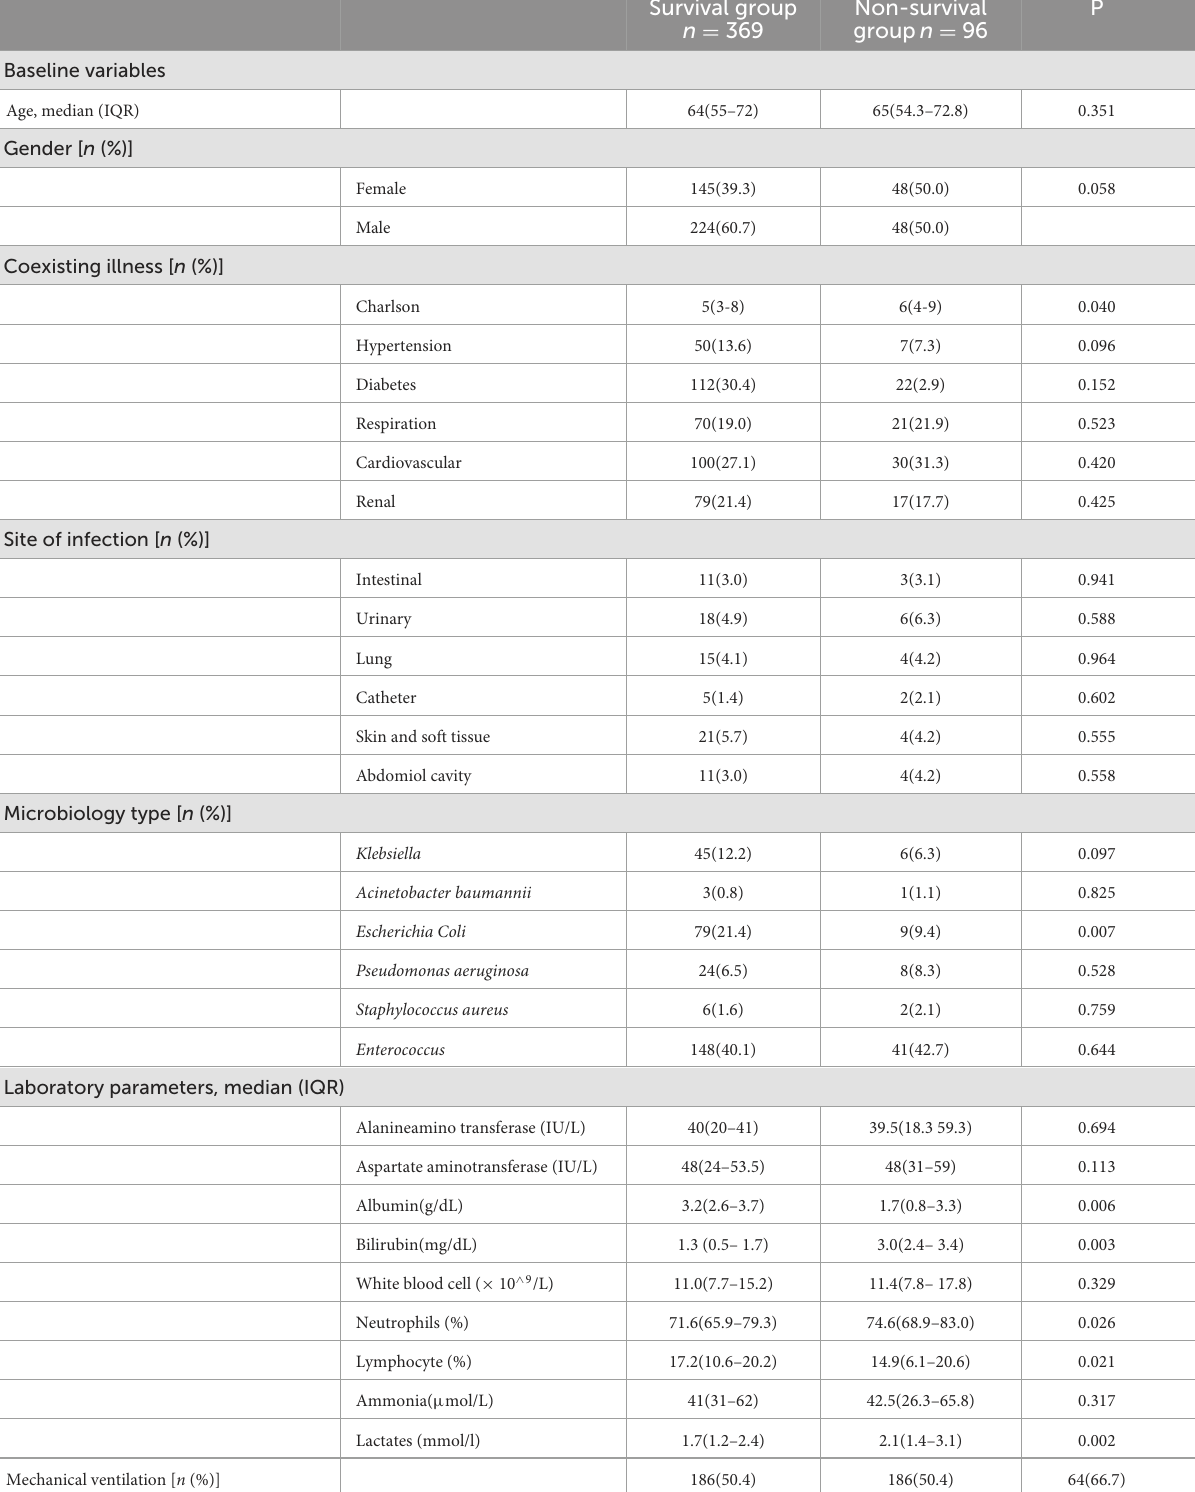
TABLE 1 Baseline characteristics and outcome of patient with